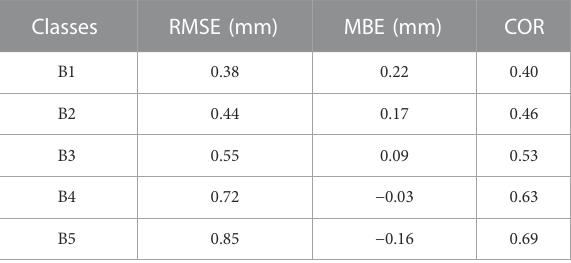
TABLE 6 Comparison of RMSE, MBE, and COR among the fi ve relative humidity classes (B1 – B5).